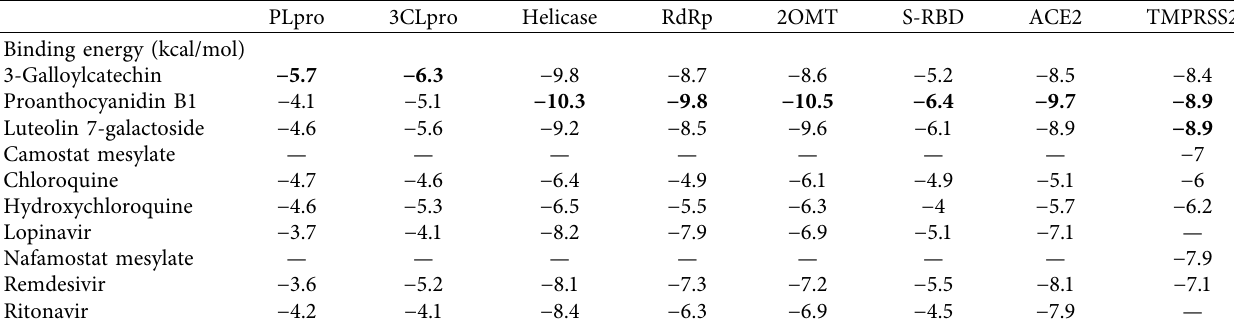
Table 2: Docking results of ligands and standard drugs on SARS-CoV-2 therapeutic targets.